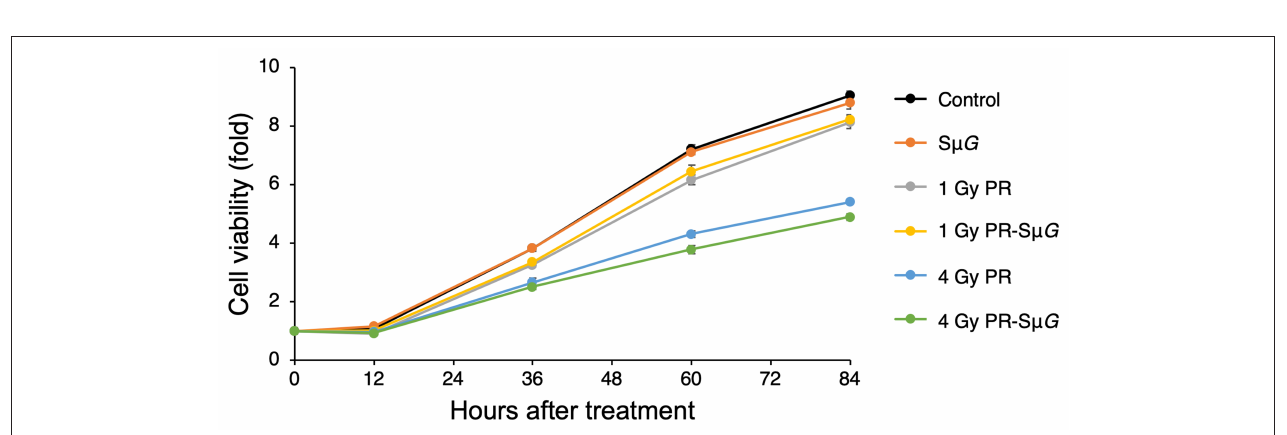
FIGURE 1 | Experimental schedule. After 1 day of incubation, the cells were exposed to proton beams, and 1 G or S µ G was immediately applied for 2 days. All the samples were subjected to subsequent analysis.